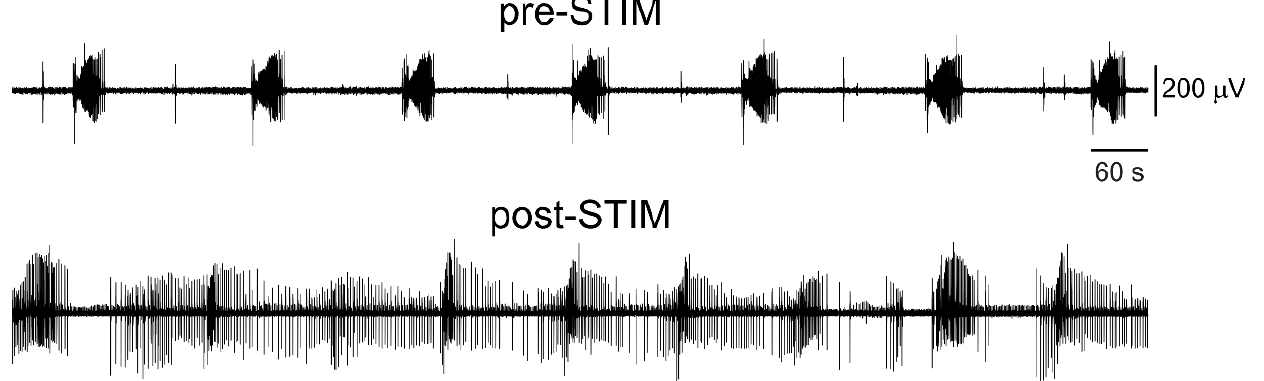
Figure A1. Partial recovery following electrical stimulation. Representative recording from the CTX of one brain slice in which ictal activity did not recover upon stimulus (STIM) withdrawal. In the pre-STIM condition, the brain slice generates recurrent, full-blown ictal discharges, along with a few slow interictal events. In the post-STIM period, the CTX no longer generates such events; the electrical pattern is instead made of barrages of slow interictal events and clusters of population bursts representing clear deteriorated ictal activity.